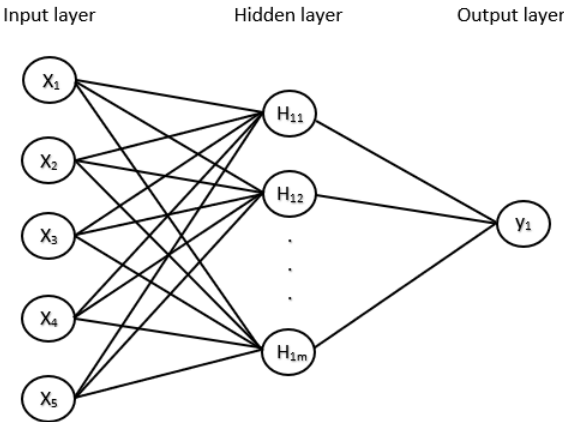
Figure 5. ANN Figure 5. ANN architecture.